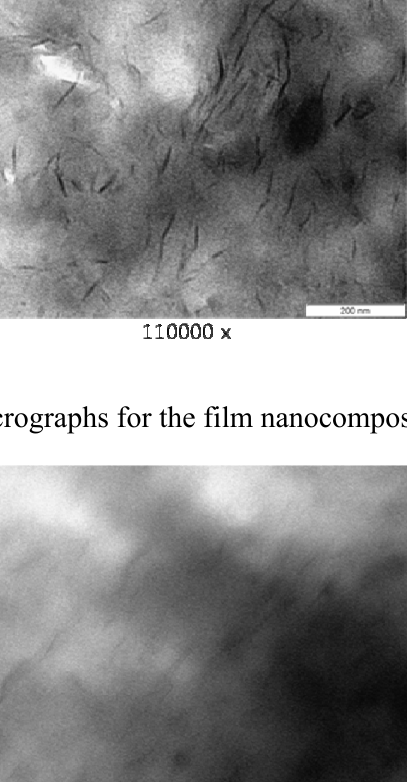
Figure 6. TEM photomicrographs for the film nanocomposite PA6/OMMT-Cet.